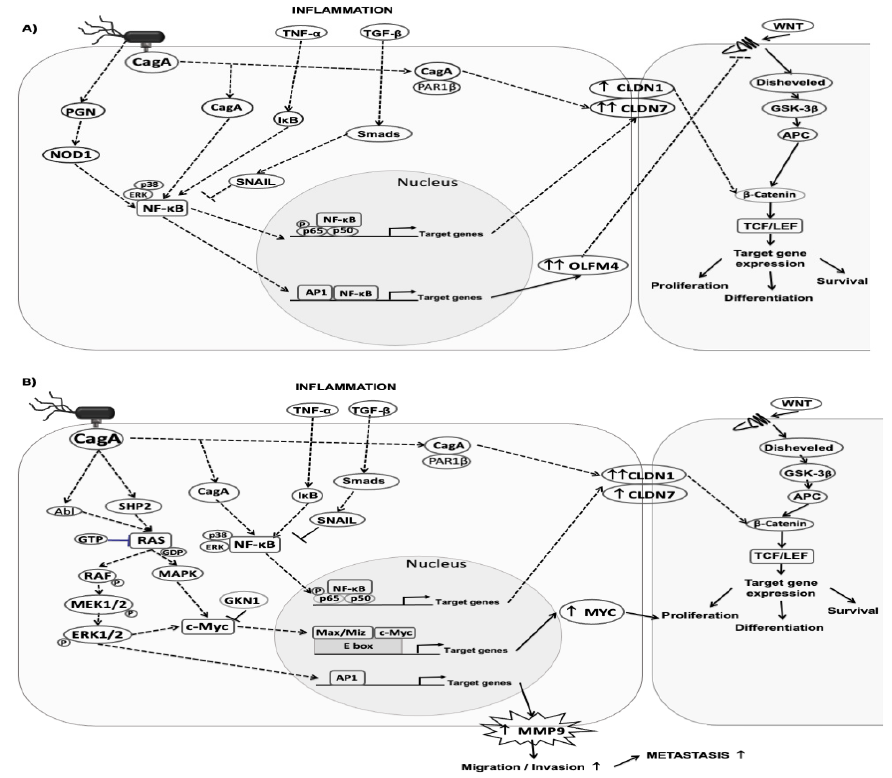
Figure 6. Hypothetical mechanisms of pathogenesis induced by H. pylori infection. ( A ) Possible mechanism of claudin-7 ( CLDN7 ) and olfactomedin-4 ( OLFM4 ) in chronic atrophic gastritis. ( B ) Scheme of possible mechanism of claudin-1 ( CLDN1 ), MYC ( C-MYC ), and matrix metalloproteinase-9 ( MMP9 ) in gastric cancer.